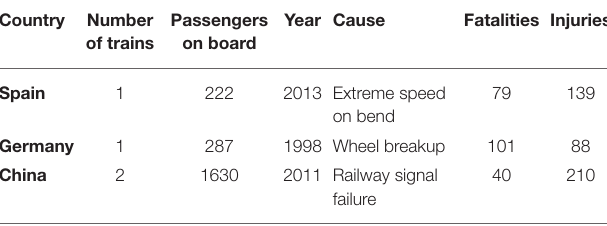
TABLE 9 | The main characteristics of the fatal HSR accidents. Country Number Passengers of trains on